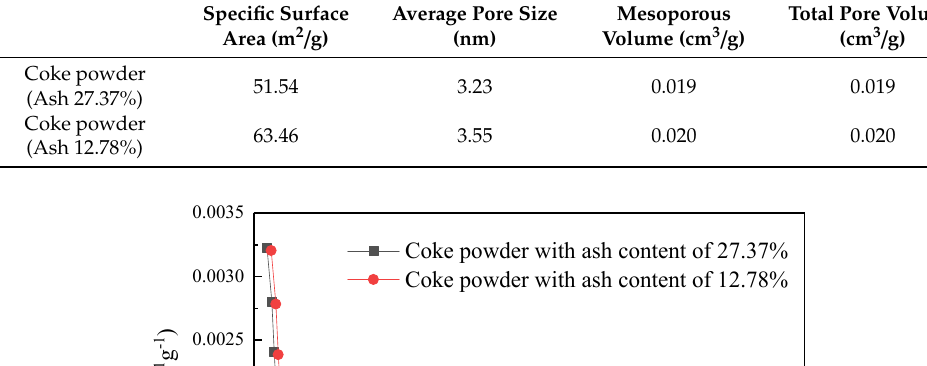
Figure 3. N 2 adsorption/desorption isotherm of coke powder. Table 3. Brunauer-Emmett-Teller (BET) analysis of coke powder.